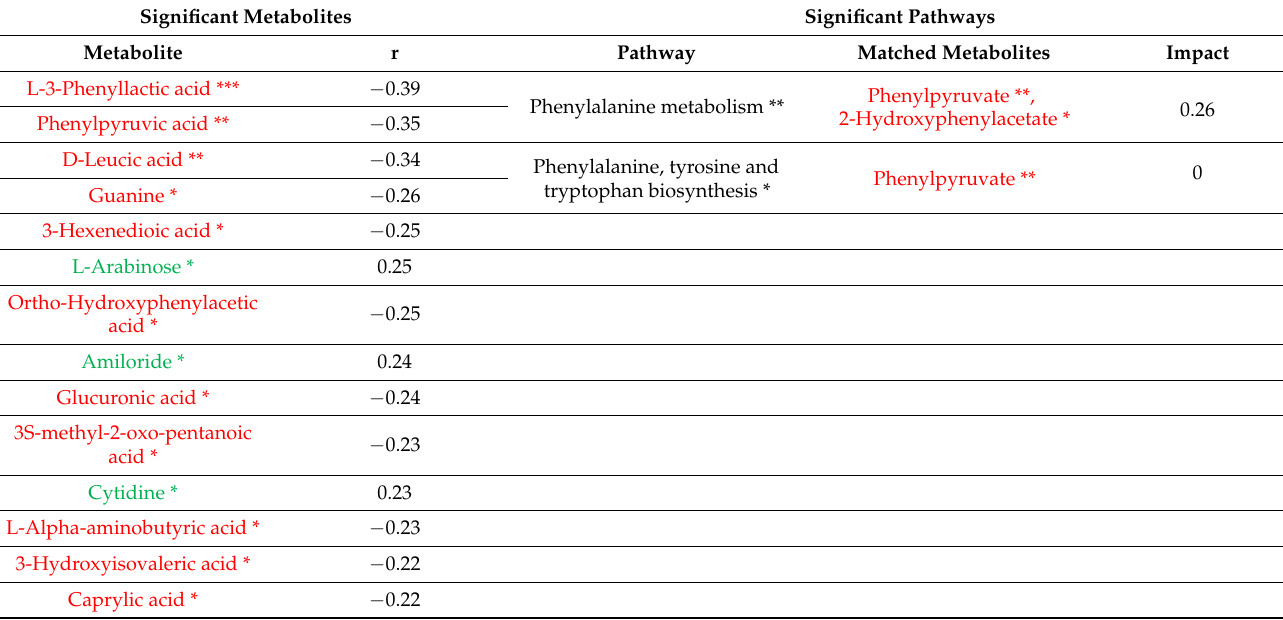
Figure 6. Metabolite-metabolite interaction network for significant metabolites that correlate to Language ability. Size of the node indicates importance in the network. The interaction analysis reveals the importance of both energy and purine metabolism. Table 9. Metabolites and their pathways which correlate with aberrant